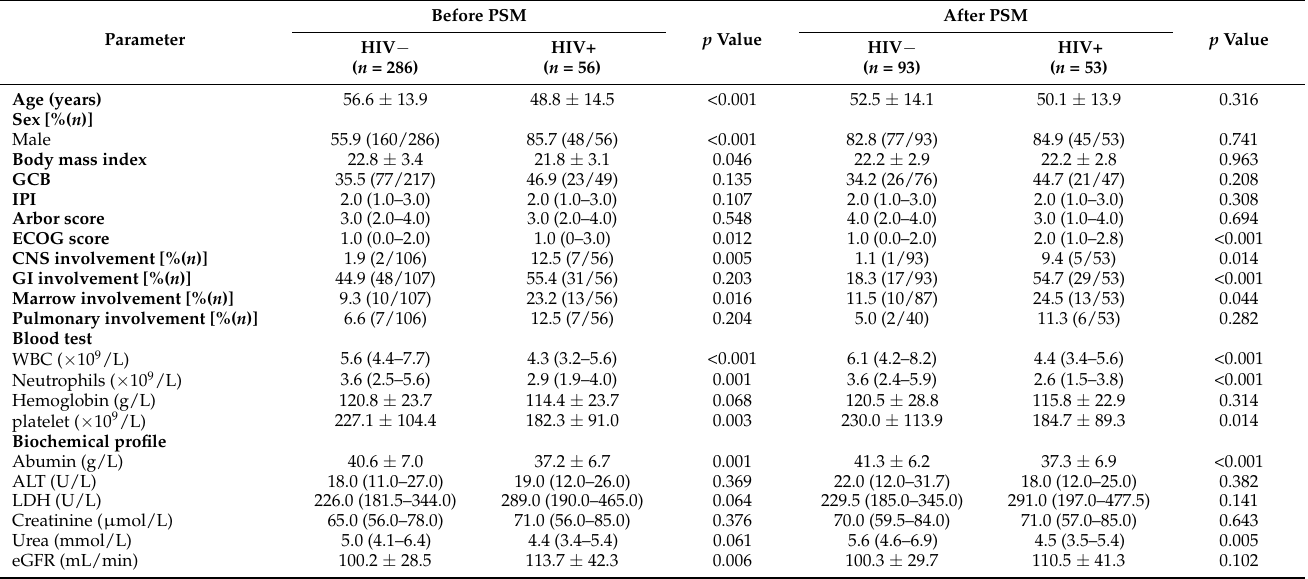
Table 1. The demographic characteristics of NHL patients with and without HIV